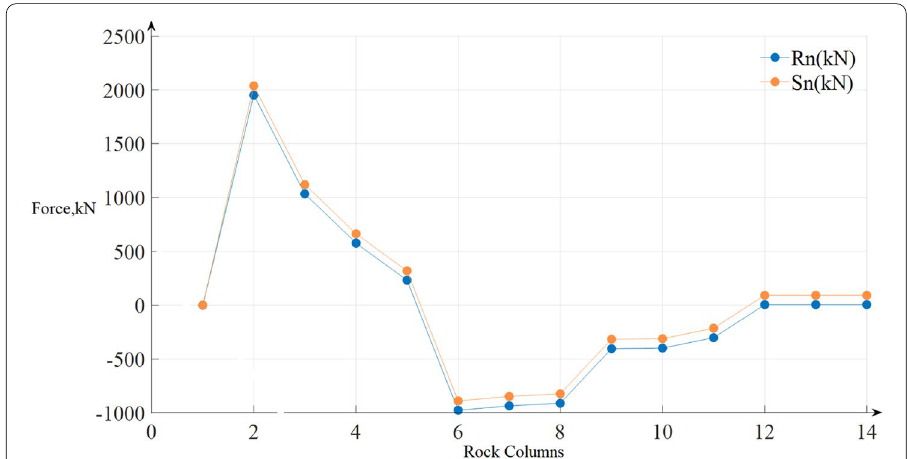
Fig. 11 Distribution of normal (R) and shear (S) forces on the bases of blocks under the influence of groundwater and stabilization from the toe of the